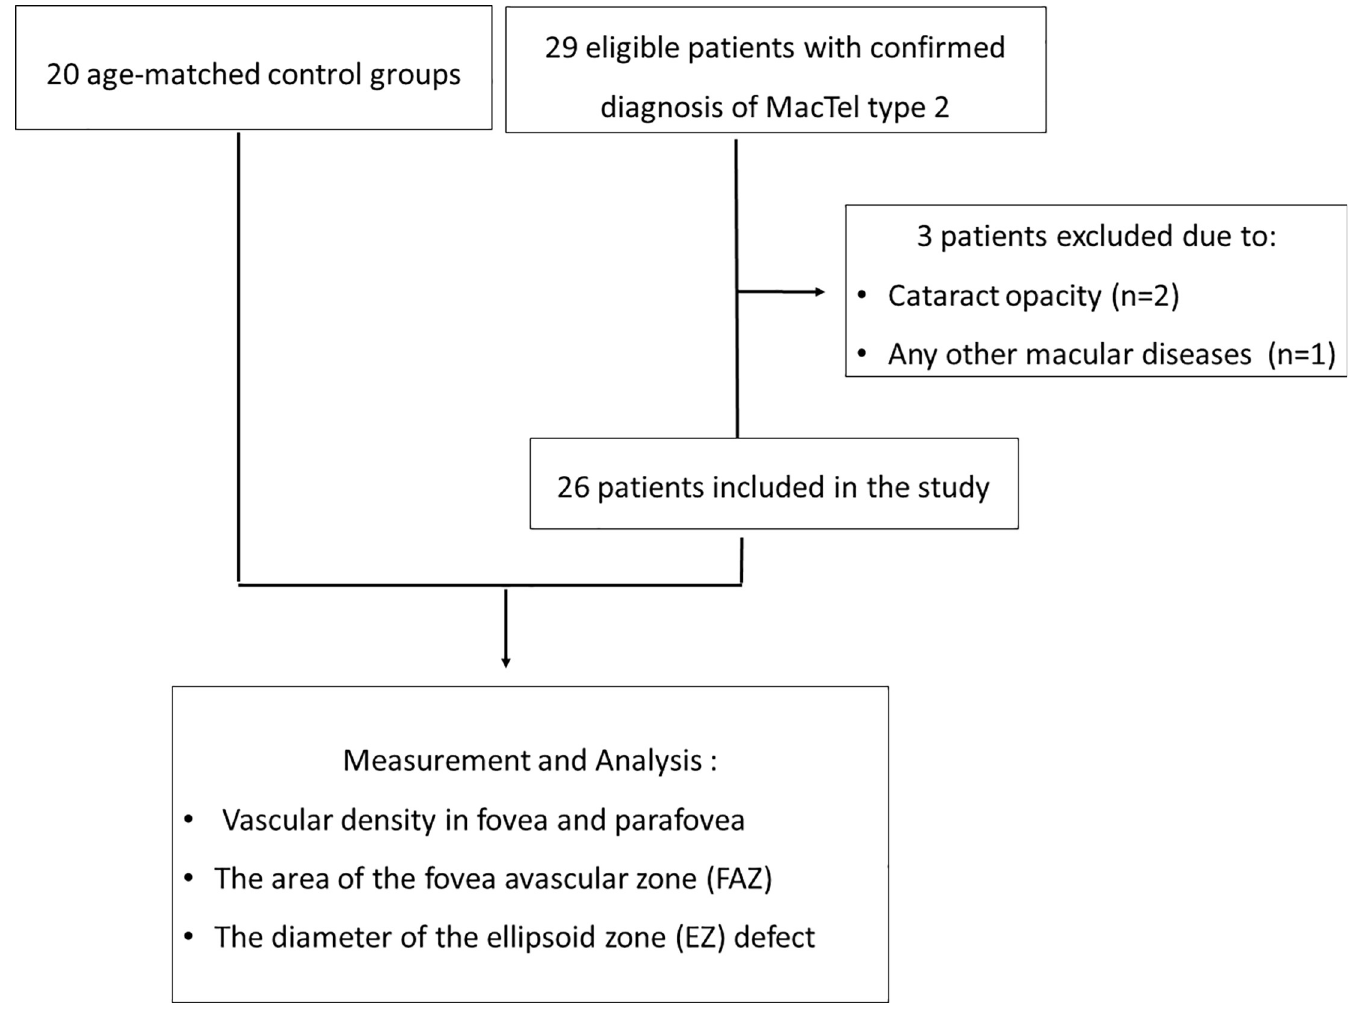
Fig 1. Study flow